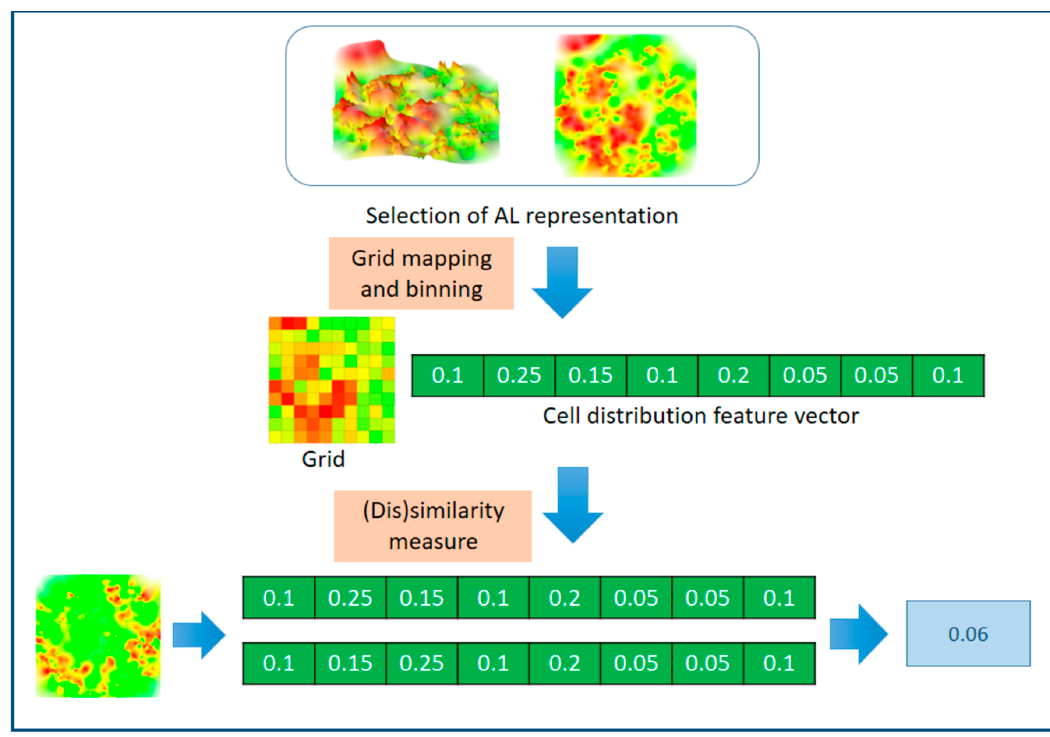
Figure 1. Three-dimensional activity landscape (AL) image-based similarity assessment. The schematic illustrates similarity analysis involving the conversion of 3D AL images into heatmaps, grid-based classification of heatmap cells according to different color intensity thresholds, and quantitative comparison of the resulting cell distribution feature vectors as a measure of AL (dis)similarity.